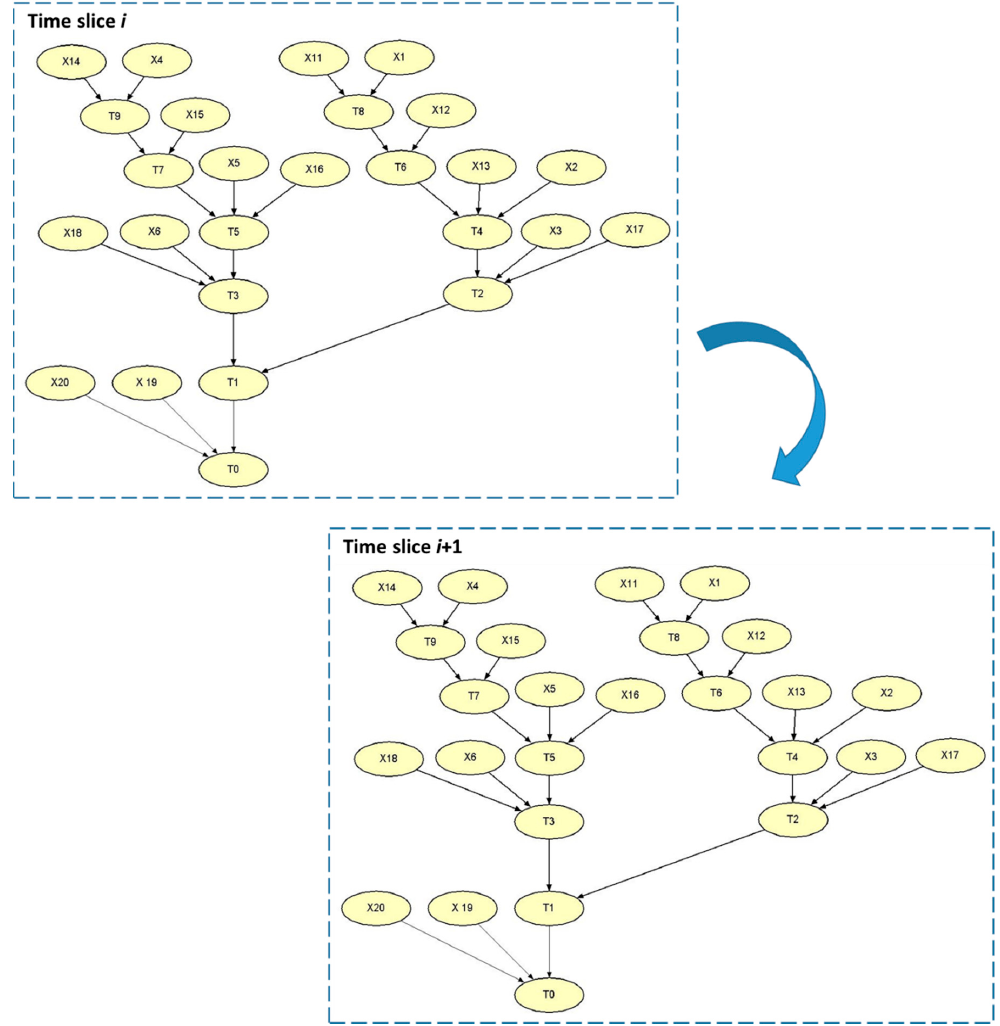
Figure 7. BN of energy transfer system.